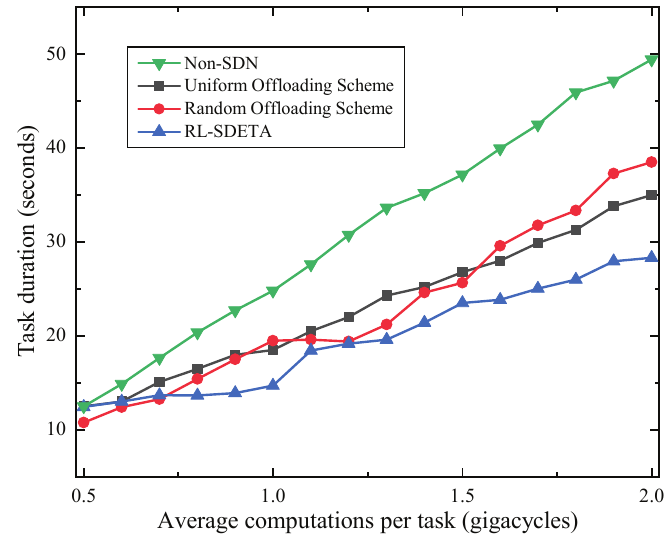
Figure 4. Impact of calculation amount on task